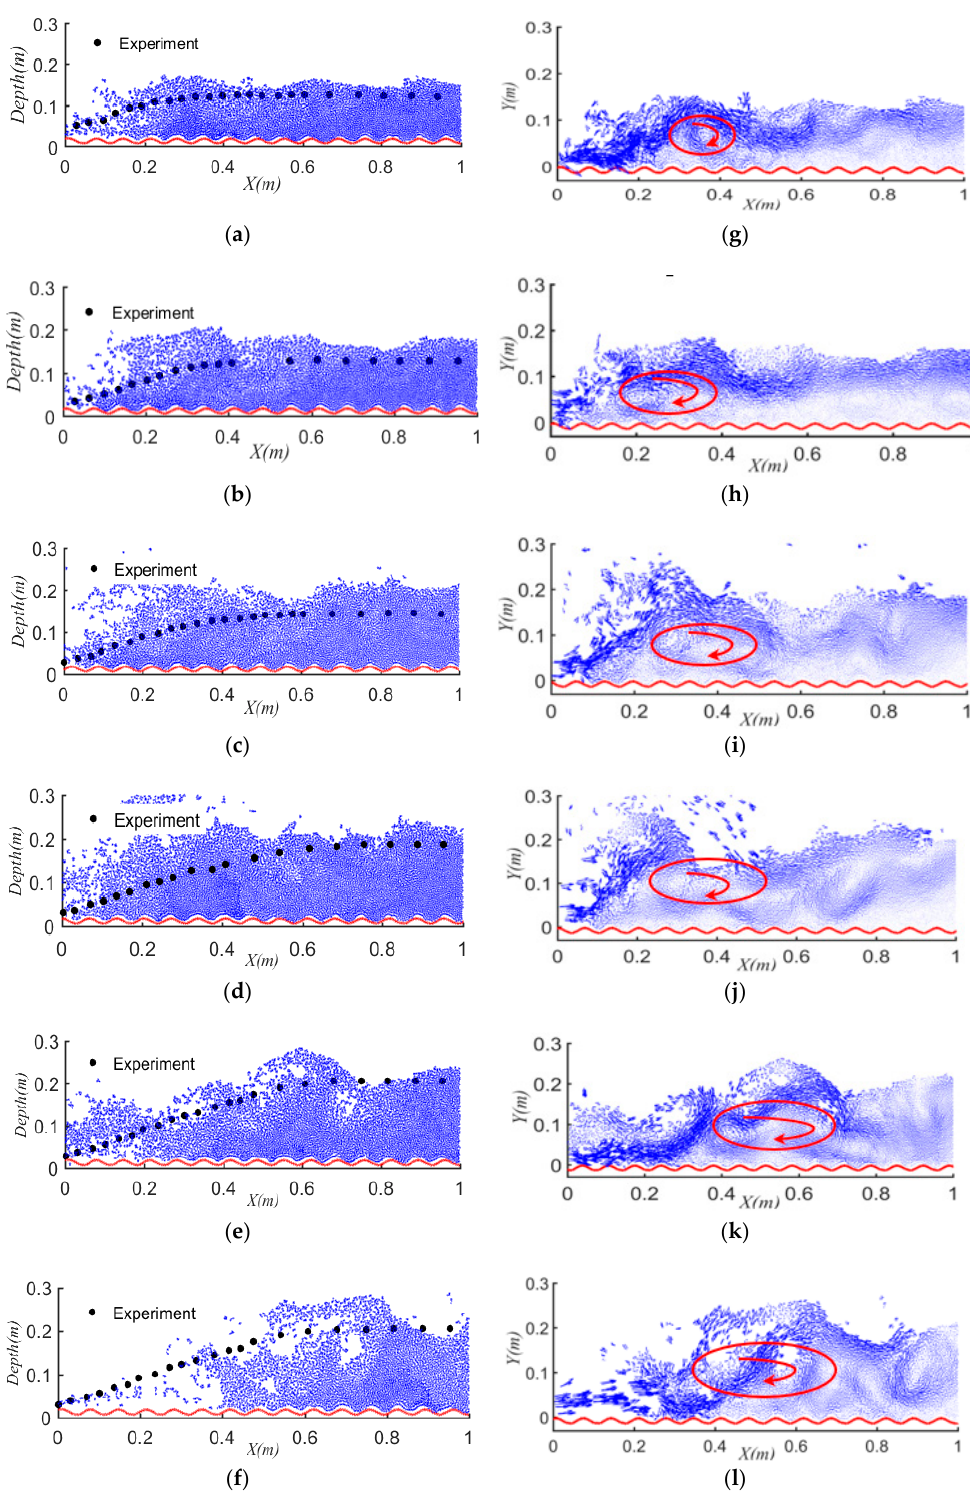
Figure 5. Wave profiles and velocity vector of different cases. ( a ) Wave profile of Case A; ( b ) Wave profile of Case B; ( c ) Wave profile of Case C; ( d ) Wave profile of Case D; ( e ) Wave profile of Case E; ( f ) Wave profile of Case F; ( g ) Velocity vector of Case A; ( h ) Velocity vector Case B; ( i ) Velocity vector of Case C; ( j ) Velocity vector of Case D; ( k ) Velocity vector of Case E; ( l ) Velocity vector of Case